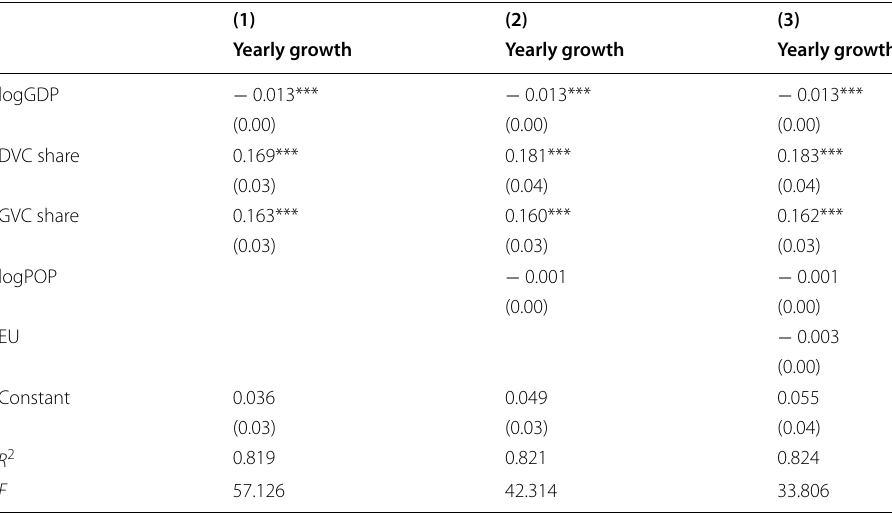
Table 1 Regression results Source: WIOD, 2016; WB; own